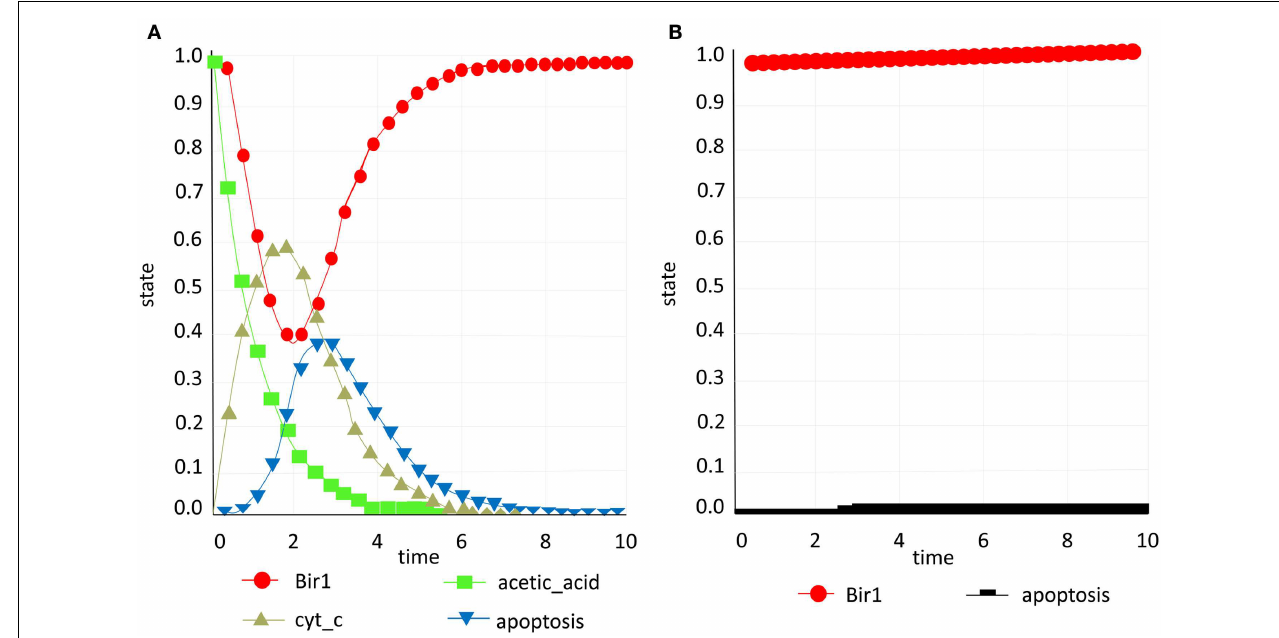
FIGURE 5 | Bir1 study. (A) Acetic acid (green) is applied as a pulse stimulus (that is then decreasing over time) and cytochrome c (yellow) present in the cytosol increases, the decrease of Bir1p (red) promotes apoptosis (B) Constant presence of Bir1p (red) inhibits apoptosis (black), validating Bir1 anti-apoptotic